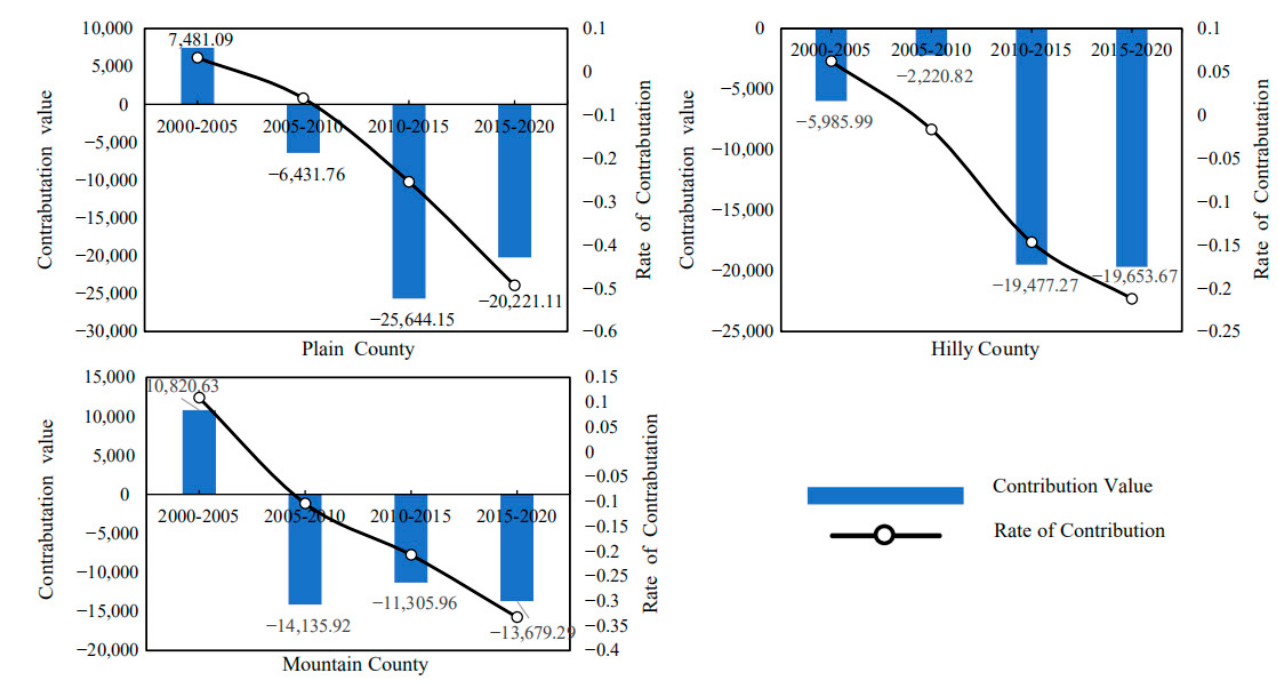
Figure 11. Topographic heterogeneity of agricultural production efficiency and emission reduction effect (including Plain County, Hilly County, Mountain County).